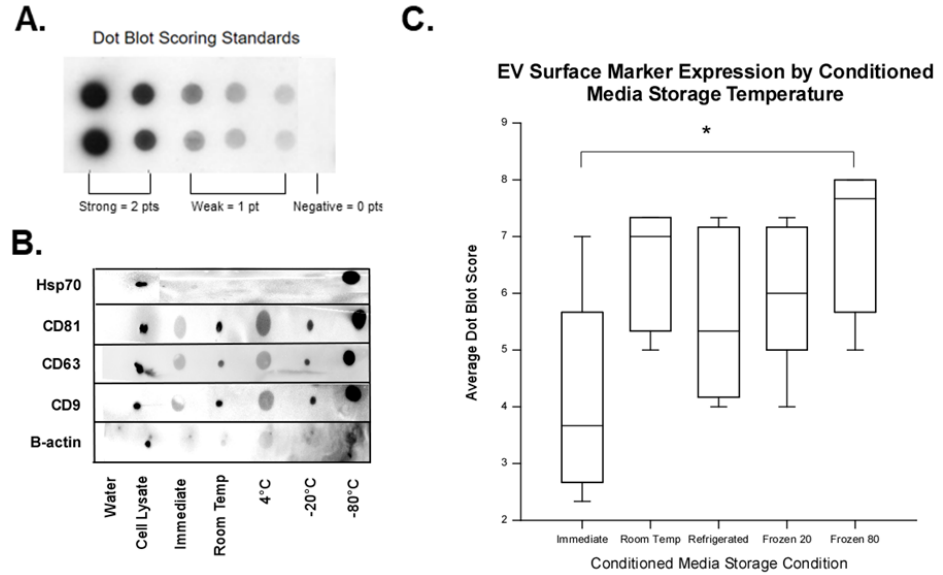
Figure 6. Effect of CM storage condition on dot blot staining. ( A ) Dot blot scoring standard provided to independent, blinded scorers to assess the intensity of EV characterization marker staining. Strong positive staining was assigned 2 points, weak positive staining was assigned 1 point, and negative staining 0 points. ( B ) Representative dot blots showing the expression of tetraspanins: clusters of differentiation (CD)9, CD63, and CD81; heat shock protein (Hsp) 70; and protein loading control beta actin (β -actin) by (left to right): water (negative control), whole MSC lysate (positive control), EVs isolated from CM of MSCs at storage conditions (immediate, room temperature, 4 °C, − 20 °C and − 80 °C). Note that while equal amounts of protein were blotted on the membrane, the − 80 °C storage condition had the strongest apparent staining. ( C ) Dot blot intensity scores were averaged from three blinded, independent scorers and summed for each MSC line in all experimental conditions for analysis. Dots were scored on an ordinal integer scale depicted in ( A ). Maximum score (strong positive for all markers) was 8.0. Expression of β -actin was not scored as it was a positive control marker. Significant differences were detected in dot blot scores of EVs from the immediate group compared to − 80 °C group ( p = 0.005). This indicates that EVs from CM stored at − 80 °C has stronger expression of characteristic EV surface markers than EVs isolated immediately from CM. Data are presented as the median, 25th, and the 75th percentile in the box and whiskers show the 10th and 90th percentile. Potential outliers are depicted as open circles. Asterisk depicts significance ( p -value < 0.05), n = 5.